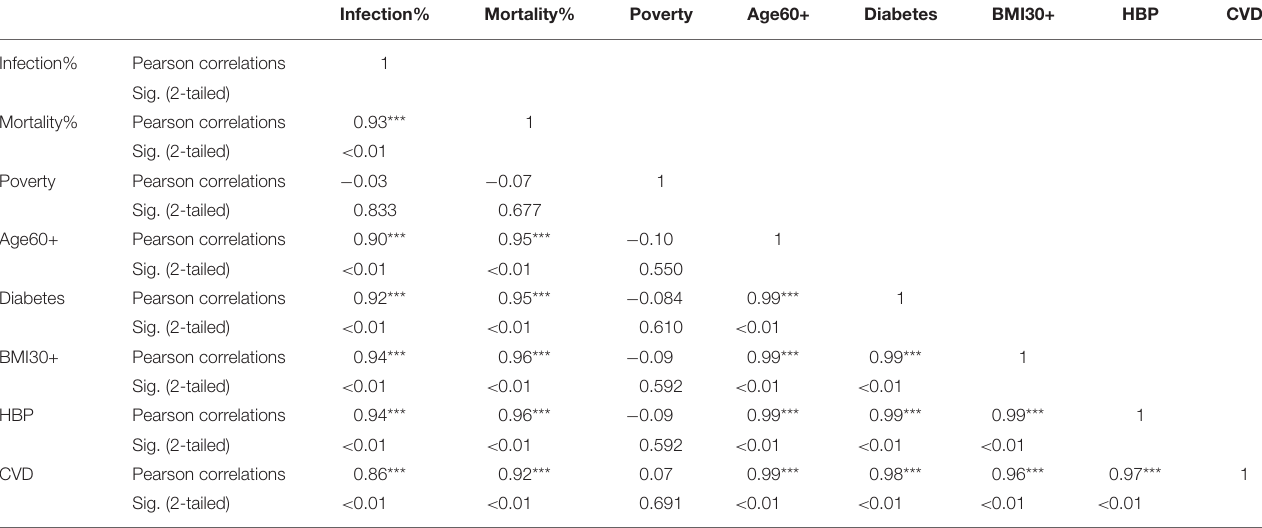
TABLE 4 | Pearson correlations for NHB ethnic group between variables used in the study and their significance